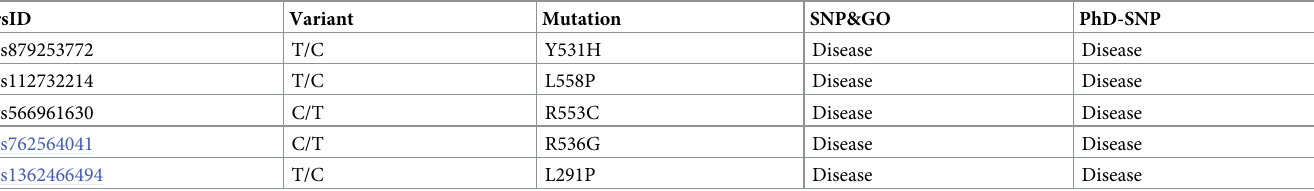
Table 2. Disease related non-synonymous SNPs identified by SNPs&GO and PhD-SNP.